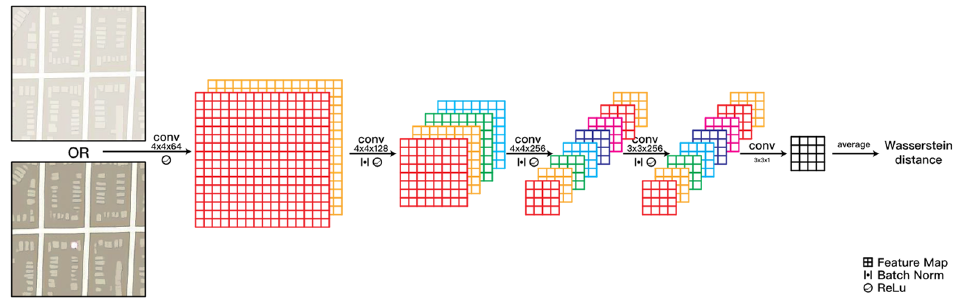
Figure 4. The structure of the discriminator D .